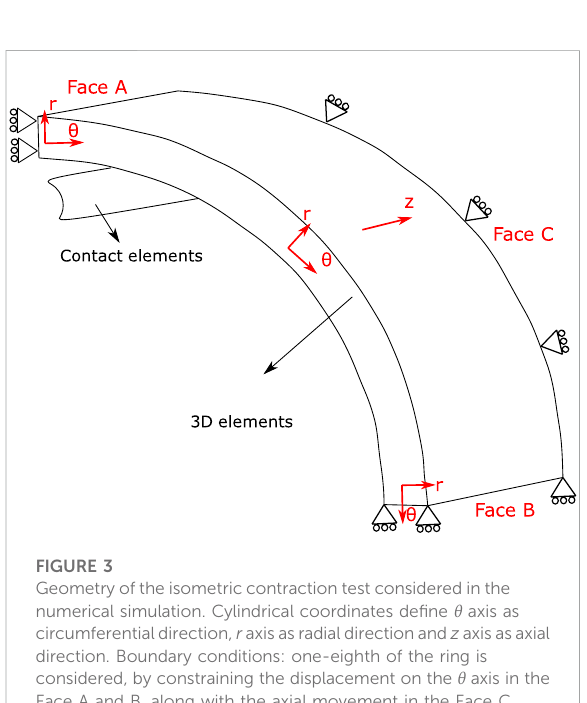
Geometry of the isometric contraction test considered in the numerical simulation. Cylindrical coordinates de fi ne θ axis as circumferentialdirection, r axisasradialdirectionand z axisasaxial direction. Boundary conditions: one-eighth of the ring is considered, by constraining the displacement on the θ axis in the Face A and B, along with the axial movement in the Face